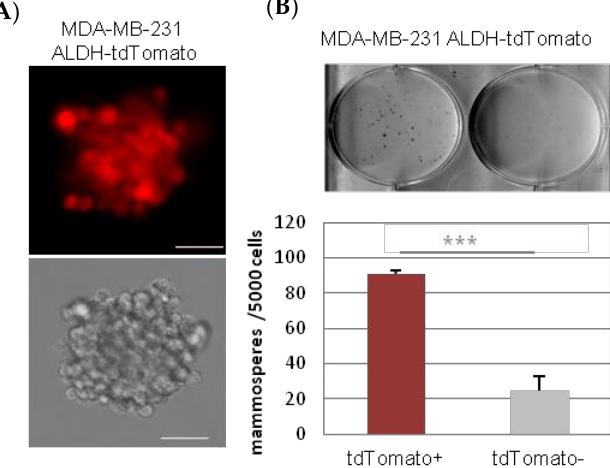
Figure 2. Mammosphere culture of tdTomato + cells. tdTomato + CSC were able to form mammospheres in low attachment plates, in serum free media. Scale bar represents 100 µ m ( A ) tdTomato + cells formed